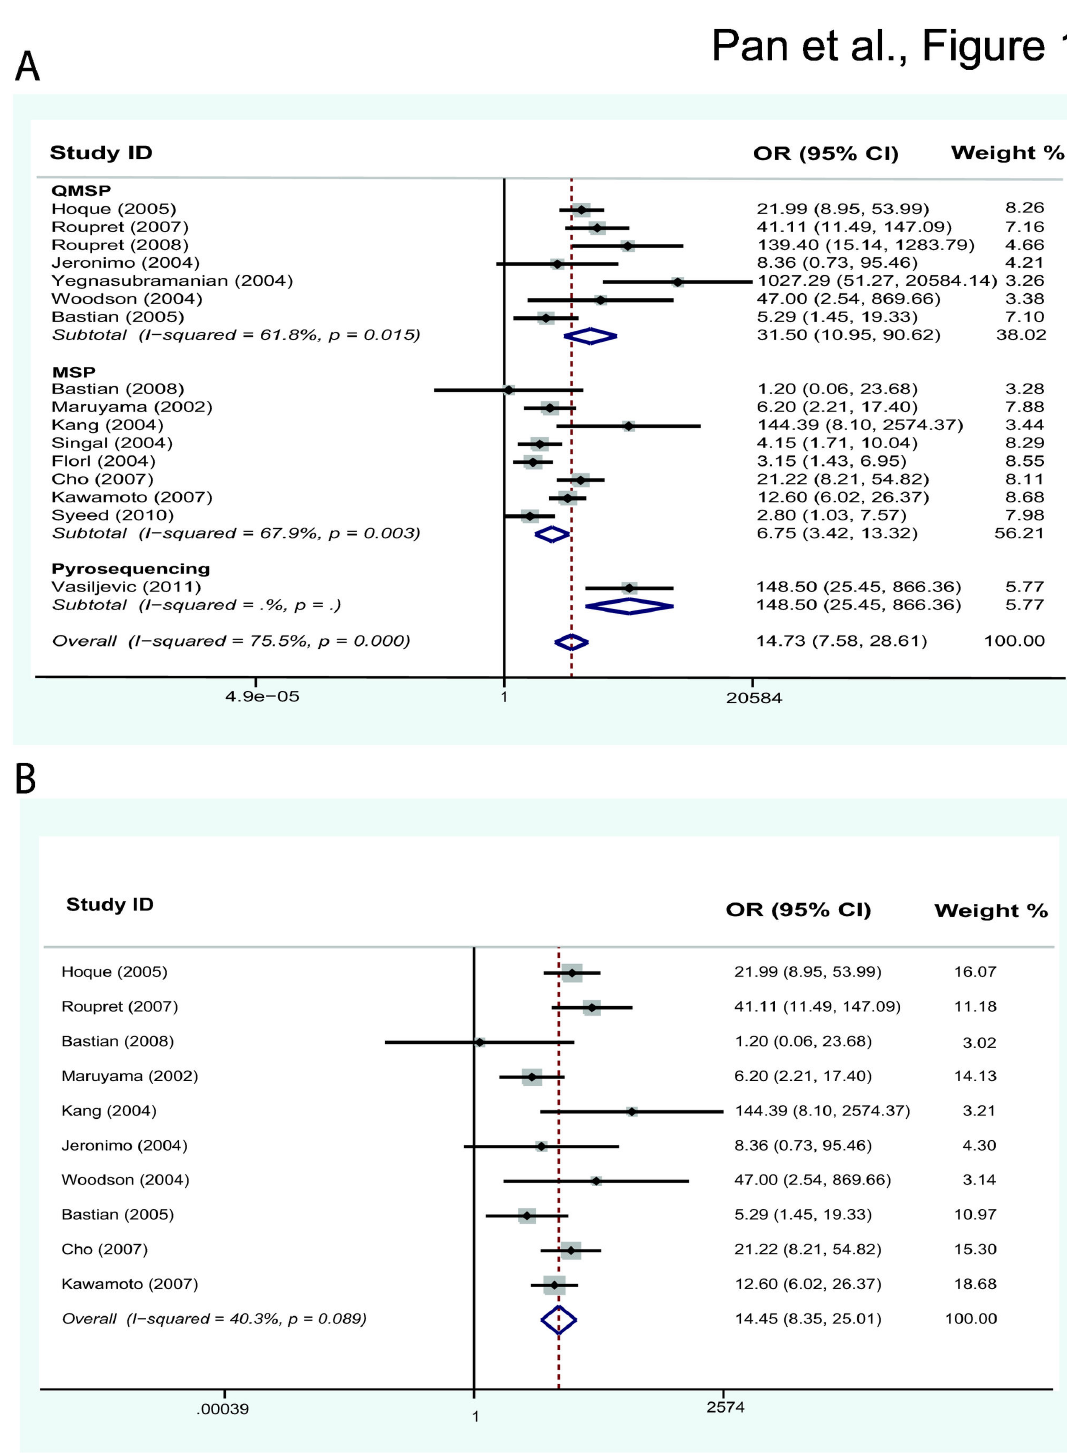
Figure 1. Forest plot showing the association between RASSF1A methylation and prostate cancer. (A) Forest plot of 16 studies showed that RASSF1A methylation was associated with PCa risk as stratified analysis by methods. (B) Forest plot after sensitivity analysis removing 6 studies showed the same risk without heterogeneity (p= 0.089). The diamond symbol represents the overall estimate from the meta-analysis and its CI (confidence interval), while its center is positioned on the value for the overall effect estimate. Diamond’s width depicts the width of the overall CI. doi: 10.1371/journal.pone.0075283.g001 PLOS ONE |